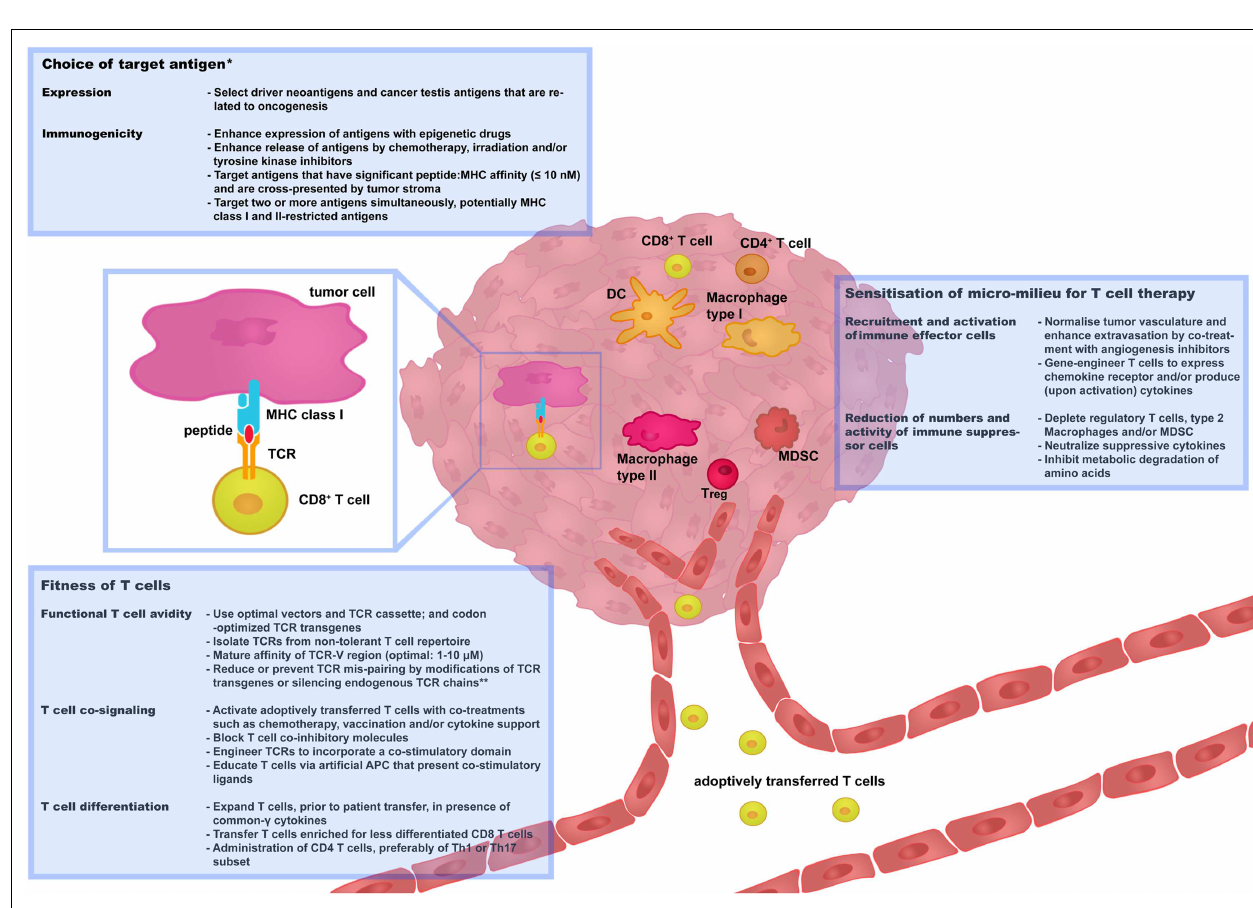
these challenges. *Independent of choice of target antigen, it is recommended to perform stringent in silico analysis and preclinical tests to confirm that healthy cells do not express the target antigen prior to proceeding with the clinical testing ofTCR-engineeredT cells. **Strategies to reduce or preventTCR mis-pairing do not only enhanceT cell avidity but also reduce the potential risk of off-target toxicity. APC, antigen-presenting cells; DC, Dendritic cells; MDSC, myeloid-derived suppressor cells;Th,T helper cells;Treg,T regulatory